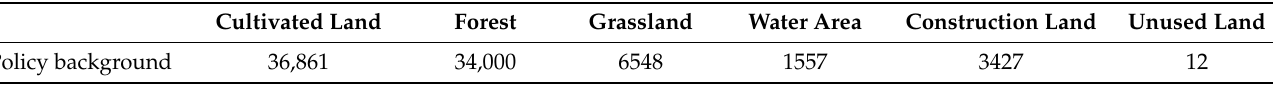
Table 5. Quantitative status of land use types in 2035 under the policy